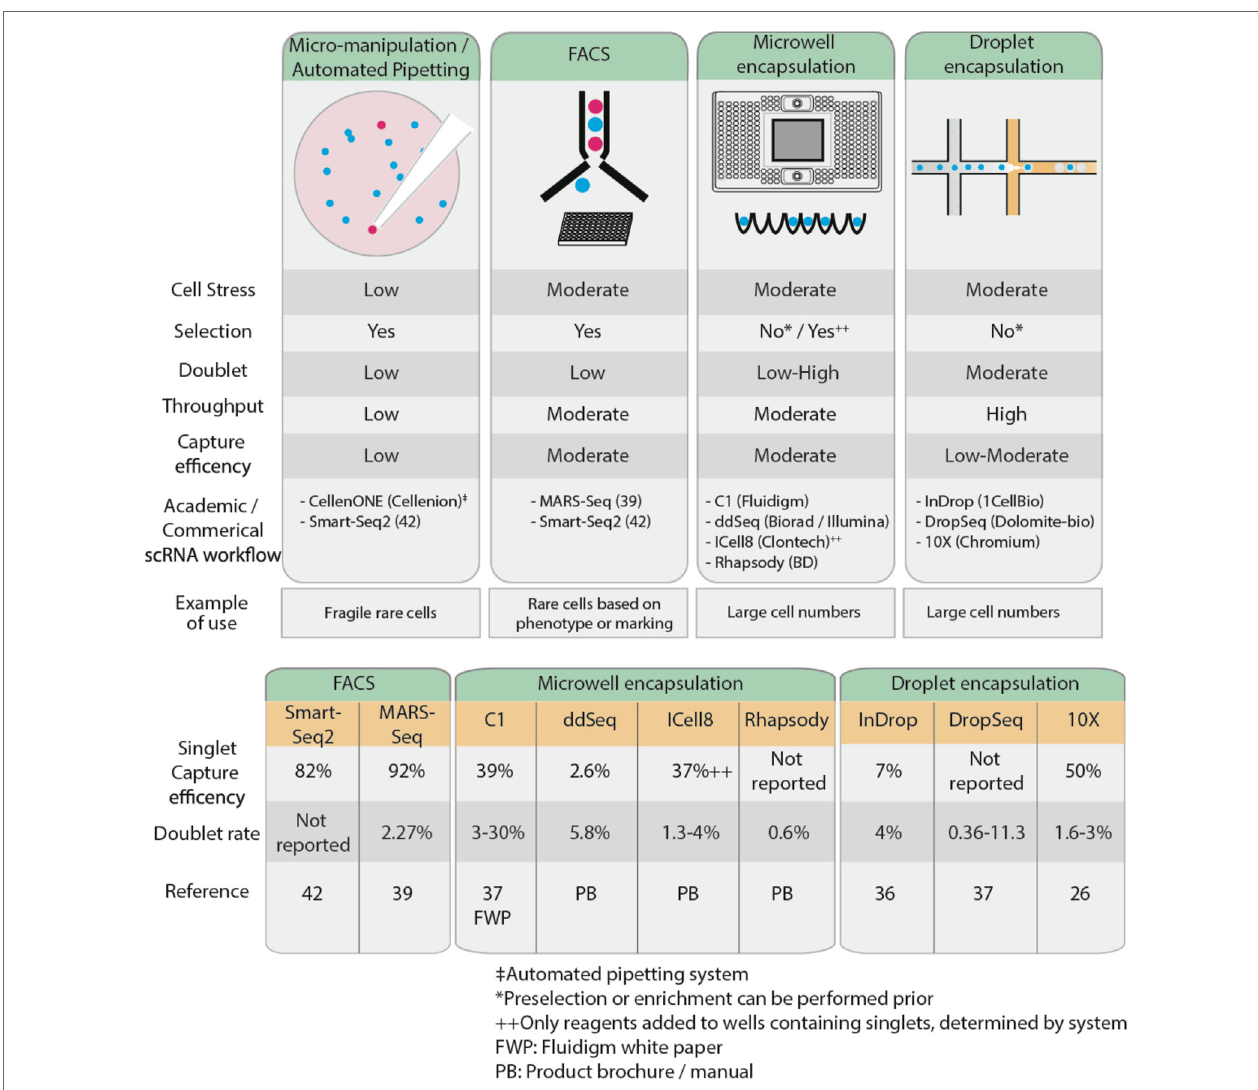
FigURe 2 | Comparison of the characteristics of several common single cell isolation methods (top), reported single cell capture efficiency and doublet rates